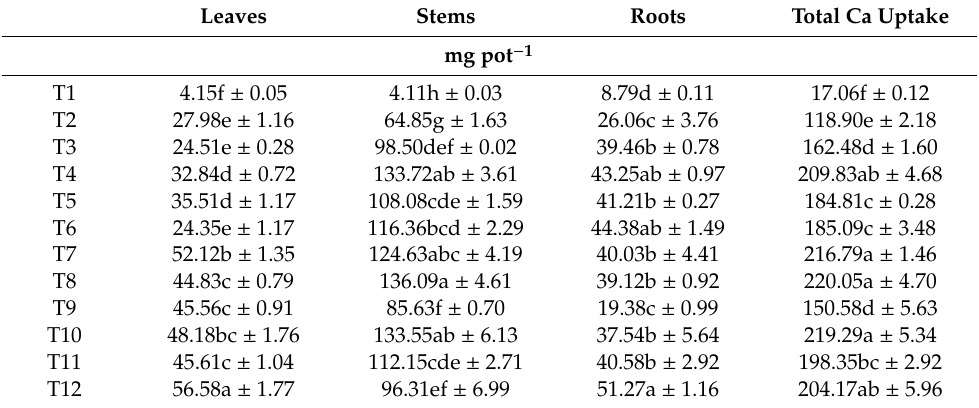
Table 7. E ff ects of treatments on calcium uptake of leaves, stems, and roots, and total calcium uptake of maize at tasseling stage.